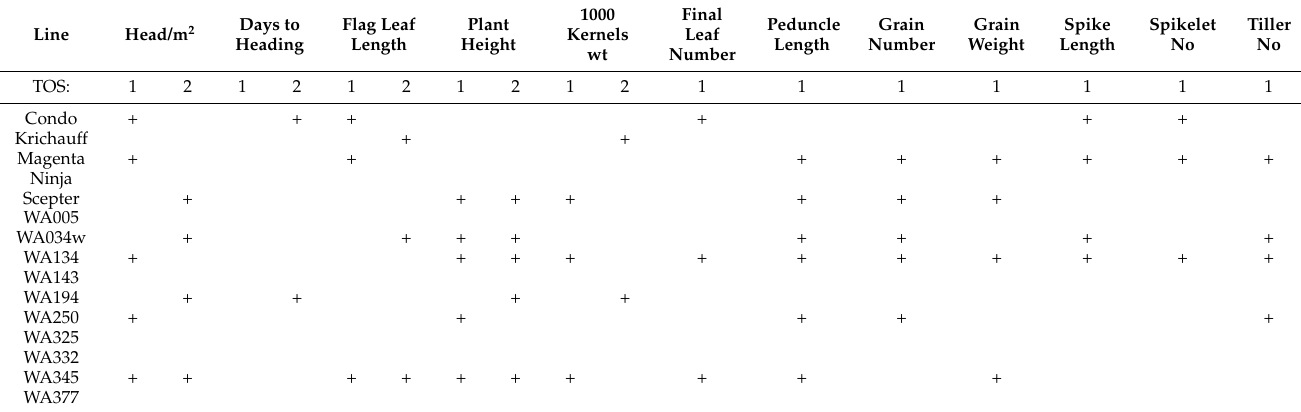
Table 3. Lines with simultaneous positive values of yield-ICT and other yield components-ICT at two times of sowing in 2019 at